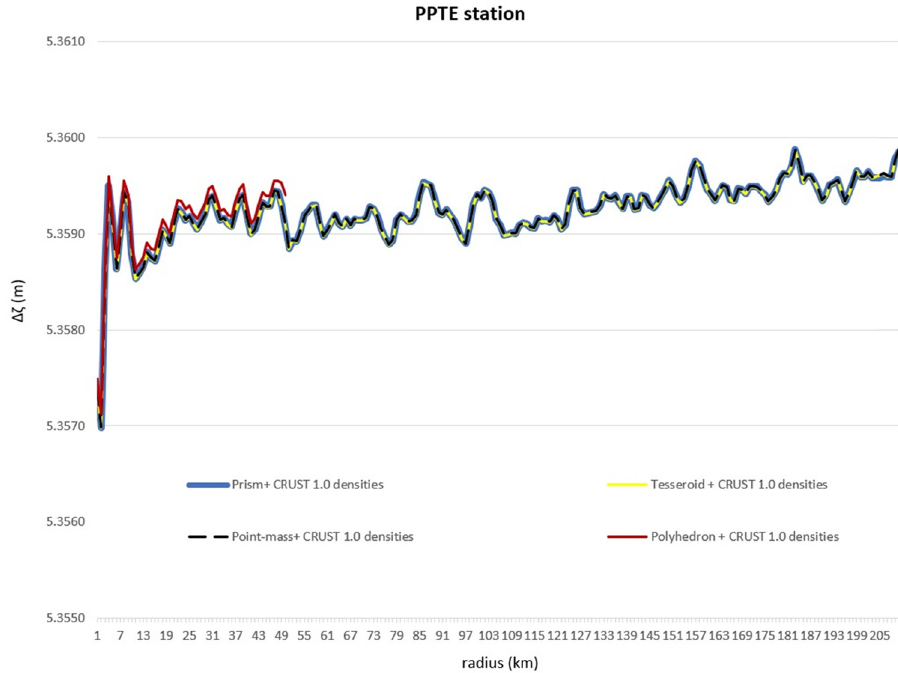
Figure 9: Di ff erences between RTM and BGS height anomalies ( Δζ ) on the integration radius intervals of each approach at PPTE station using densities provided by CRUST